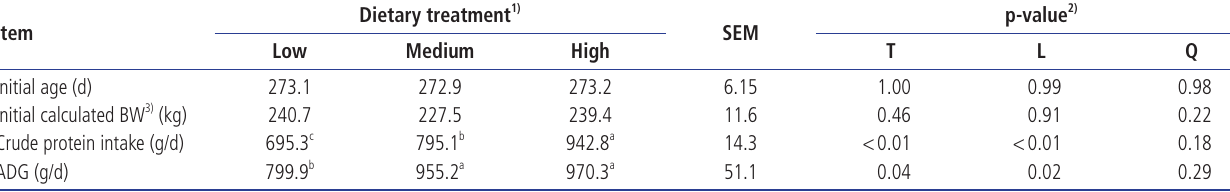
Table 2. Initial age, body weight (BW), and average daily gain (ADG) of heifers fed different dietary protein level